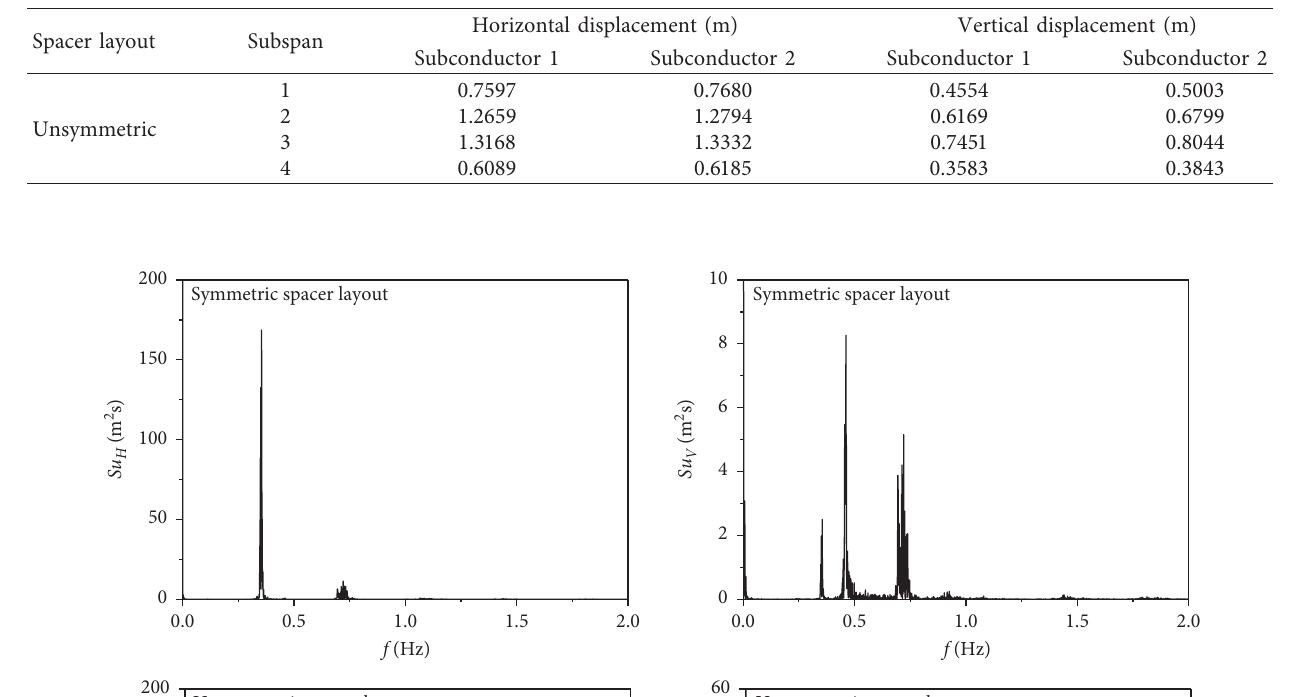
Table 8: Oscillation amplitudes at each subspan midpoint of two subconductors. ( I � 500 A, α � − 35 ° ).